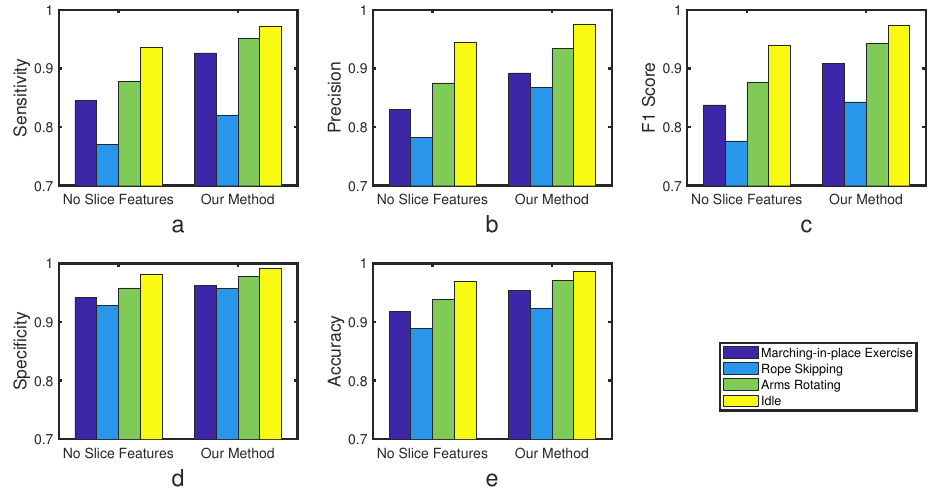
Figure 10. These figures illustrate the comparison of the classification ( a ) sensitivity, ( b ) precision, ( c ) F1-score, ( d ) specificity, and ( e ) accuracy of the four categories of WiFi signals by the RF classifier with or without the slice